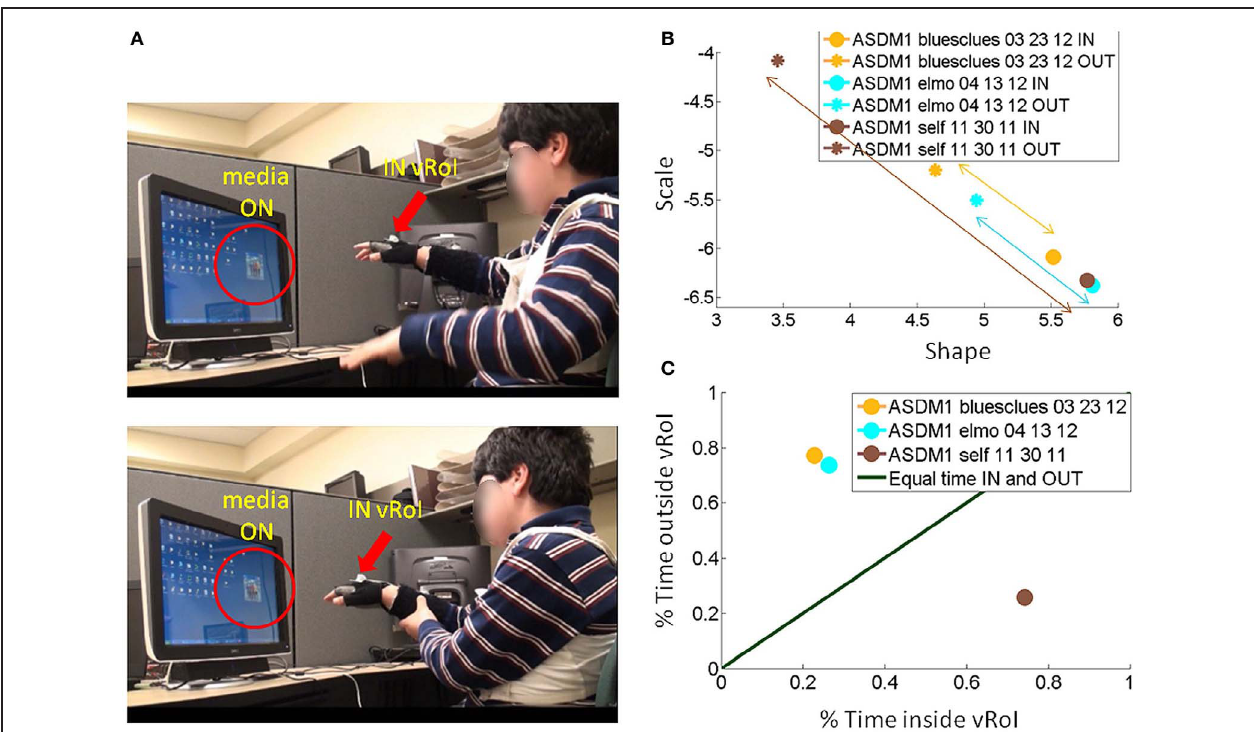
are due to viewing real time video of himself, while shifts quantified by triggering videos of “Elmo” and “Blue’s Clues” are less pronounced. (C) The longitudinal measurement of the cartoons show improvements for “Elmo” in both the Gamma plane shifts and in the percent of session time spent exploring the vRoI, yet the percent of time spent deliberately holding the hand inside the vRoI and engaging the real-time video of himself is far larger. Notice as well-that transient predictive gains in 03-23-12 are retained weeks later and improved in 04-13-12 despite no practice of the task in between.